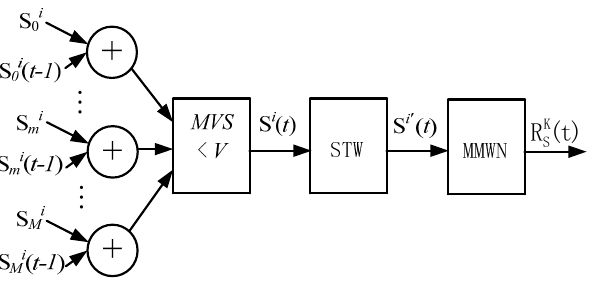
Figure 6. The stochastic multi-value model for a dynamic multi-state weighted k -out-of- n system with repairable components.